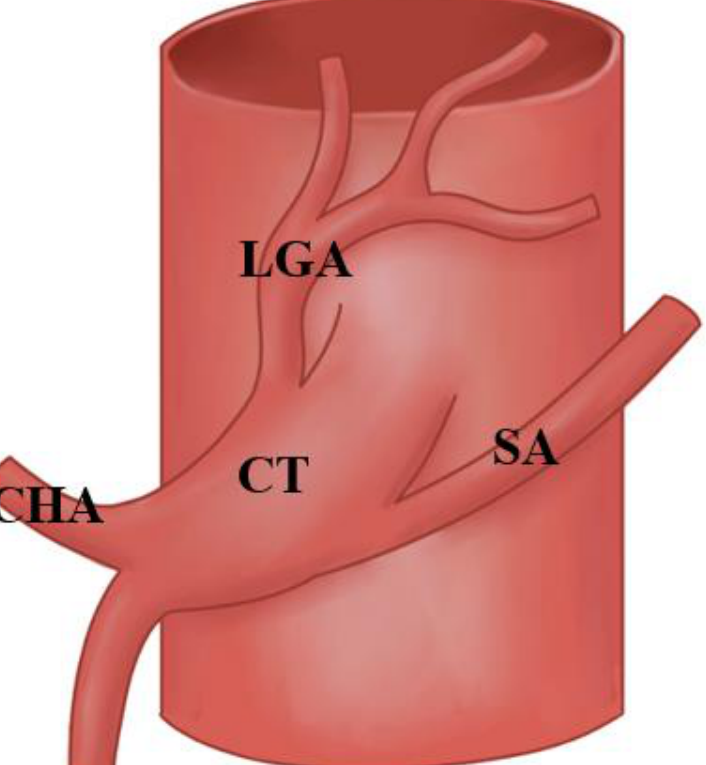
Figure 2. The image shows the hepatosplenic trunk. Abbreviations: celiac trunk (CT), splenic artery (SA), common hepatic artery (CHA), left gastric artery (LGA).